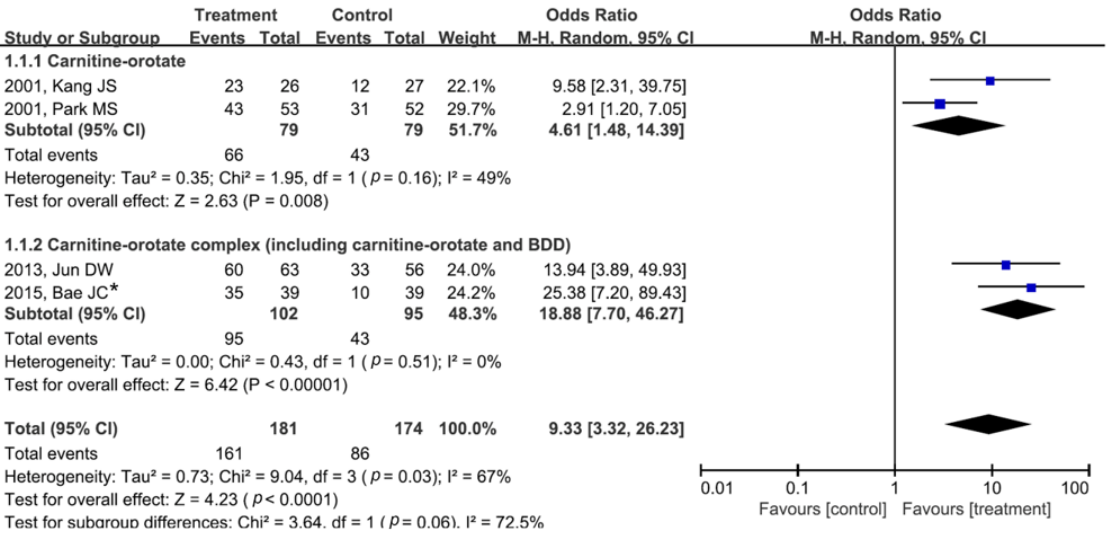
Figure 2. Forest plot of alanine aminotransferase normalization after carnitine-orotate (or carnitine- orotate complex) versus control treatment. The carnitine–orotate complex includes carnitine-orotate, BDD, and other minor supplementary compounds. The dosage of carnitine-orotate in the included studies in this analysis was 900 mg per day, which is the usual dosage for clinical purposes. * The val- ues in this study were provided by the corresponding author. BDD, biphenyl dimethyl dicarboxylate; M-H, Mantel–Haenszel; CI, confidence interval; df, degrees of